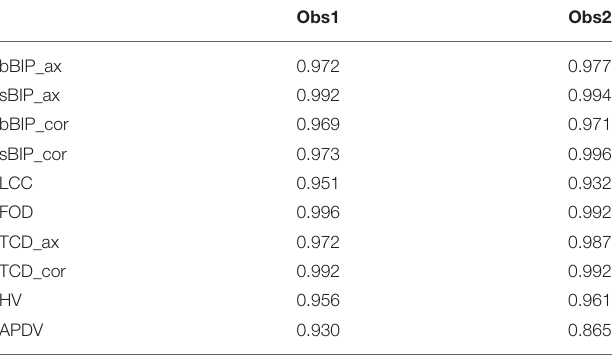
TABLE 2 | Lin’s concordance correlation coefficient